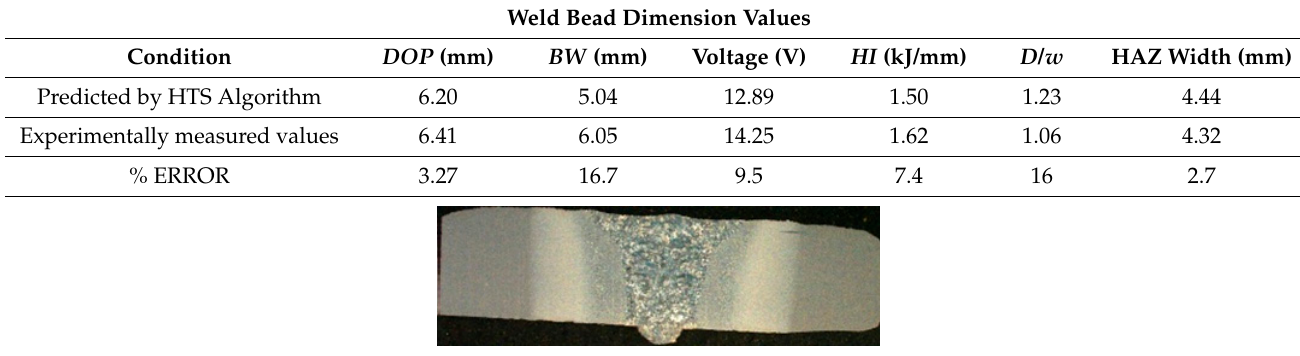
Table 9. Validation results for case study 3.